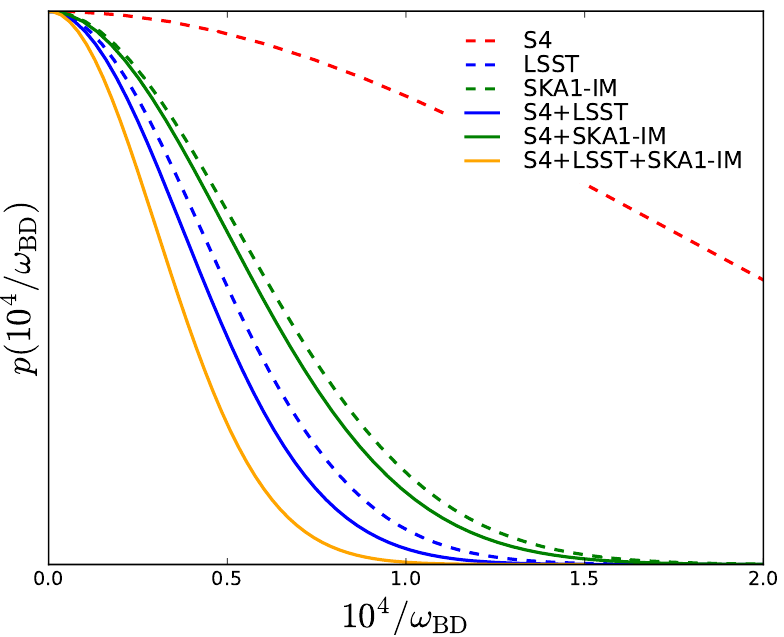
Figure 7. Posterior distribution of ω BD obtained combining a CMB-S4 survey with contemporary stage IV LSS experiments. Reprinted figure with permission from the authors of [39] by the American Physical